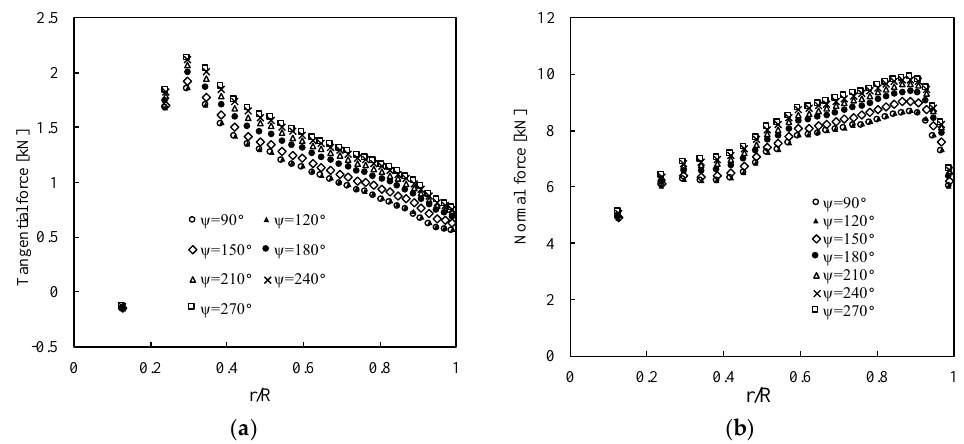
Figure 13. Tangential force and normal force at the control points in wind shear conditions. ( a ) Figure13. Tangentialforceandnormalforceatthecontrolpointsinwindshearconditions. ( a )Tangential Tangential force; ( b ) Normal force. force; ( b ) Normal force.